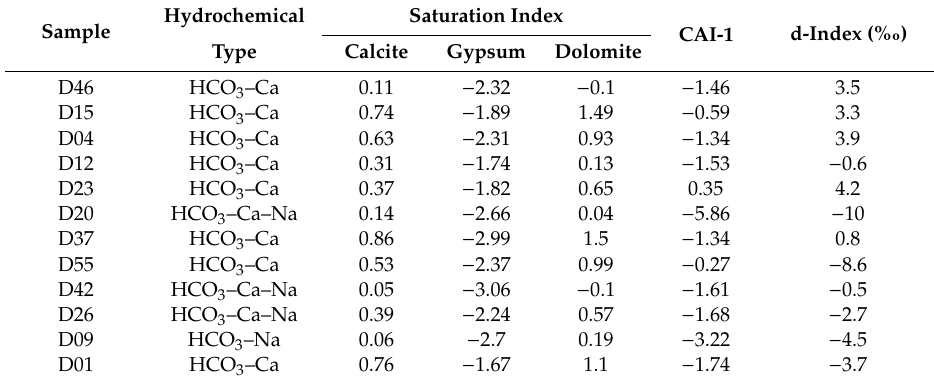
Table 1. Calculated results of hydrochemical type, saturation index, CAI-1 (chloro-alkaline) and d-index (surplus of deuterium relative to the GWML) (sample locations shown in Figure